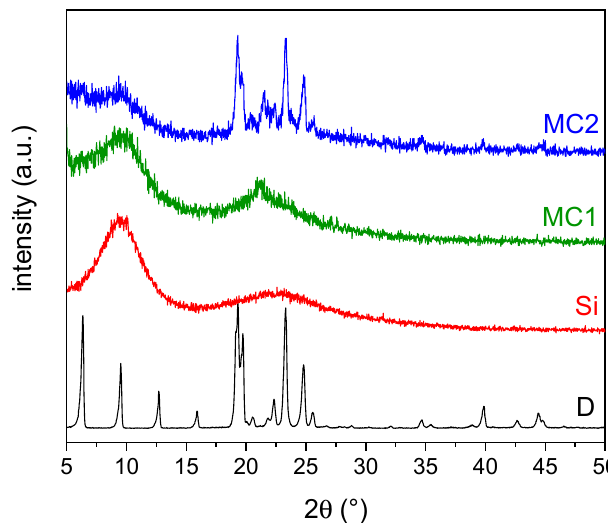
Figure 4. XRD spectra of the bulk docosane (D), MC1 and MC2 microcapsules and the neat organosilica microparticles (Si).